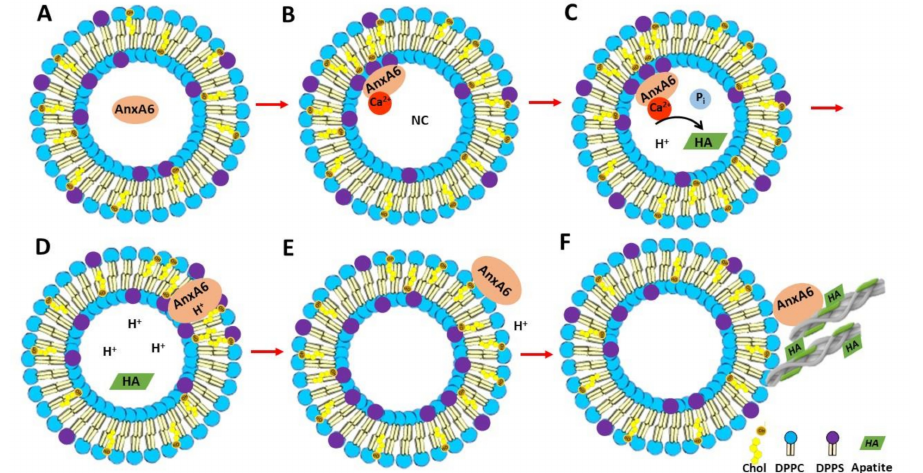
Figure 8. Representation of the mechanism of AnxA6 translocation during MV-mediated mineralization and its putative functions. ( A ) AnxA6 is localized in the lumen of MVs at low calcium concentrations. ( B ) Accumulation of calcium inside MVs favors the binding of AnxA6 to the inner leaflet of the MV membrane bilayer containing phosphatidylserine (PS) in a Ca 2 + -dependent manner, forming a nucleational core (NC) and initiating apatite formation. ( C ) During apatite formation, protons (H + ) are released, inducing the protonation of AnxA6 and rendering it more hydrophobic due to an ionization potential around 5.5. ( D ) Protonated AnxA6 can translocate within the MV bilayer where it may form an ion pore. ( E ) The pH outside MVs corresponds to that of the extracellular matrix and is neutral. AnxA6 can be deprotonated and released to the external surface of MVs enriched in phosphatidylcholine (PC). ( F ) AnxA6 binding to neutral phospholipids is Ca 2 + -independent. AnxA6 may also bind to collagen fibers, contributing to the adhesion of MVs to collagen